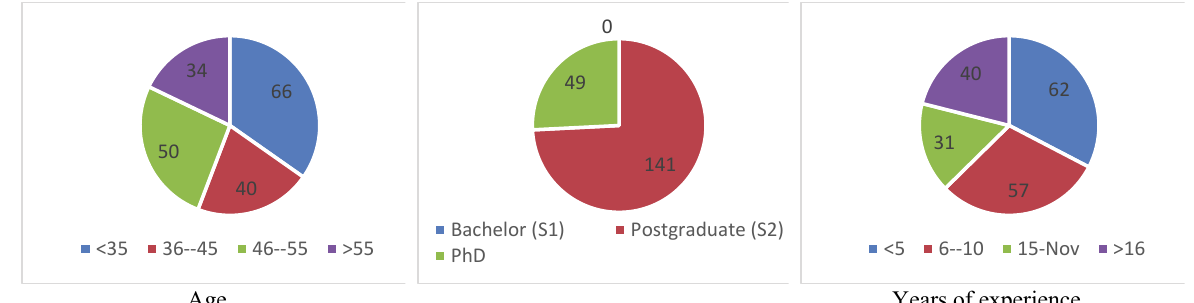
Fig. 1. Personal characteristics of the